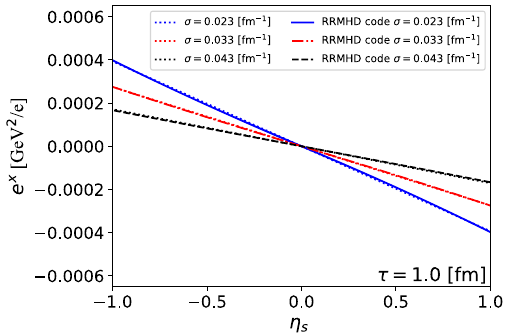
Fig. 19 The electrical conductivity dependence of the electric field component measured in the comoving frame e x at τ = 1 . 0 fm. The blue solid,redlongdashed-dottedandblackdashedlinesshowthenumerical results in the cases of σ = 0 . 023 , 0 . 033 and 0 . 043 fm − 1 , respectively. The blue, red, and black dotted lines show the semi-analytic solutions of the Eq. (82) in the cases of σ = 0 . 023 , 0 . 033 and 0 . 043 fm − 1 ,